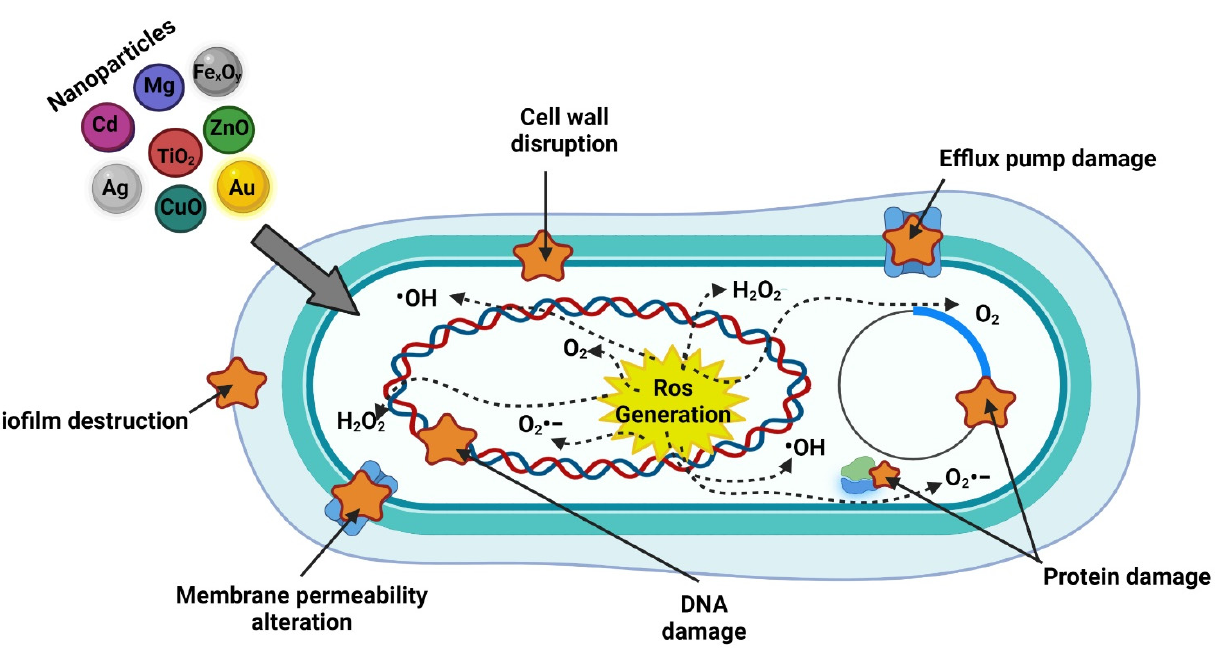
Figure 3. Action mechanism of inorganic nanoparticles. Created with BioRender.com (accessed on 17 November 2021). NPs sizes are largest than antibiotics which allow the use of these as carriers of antibiotics or other small molecules as antibodies or chemotherapeutic agents [126].